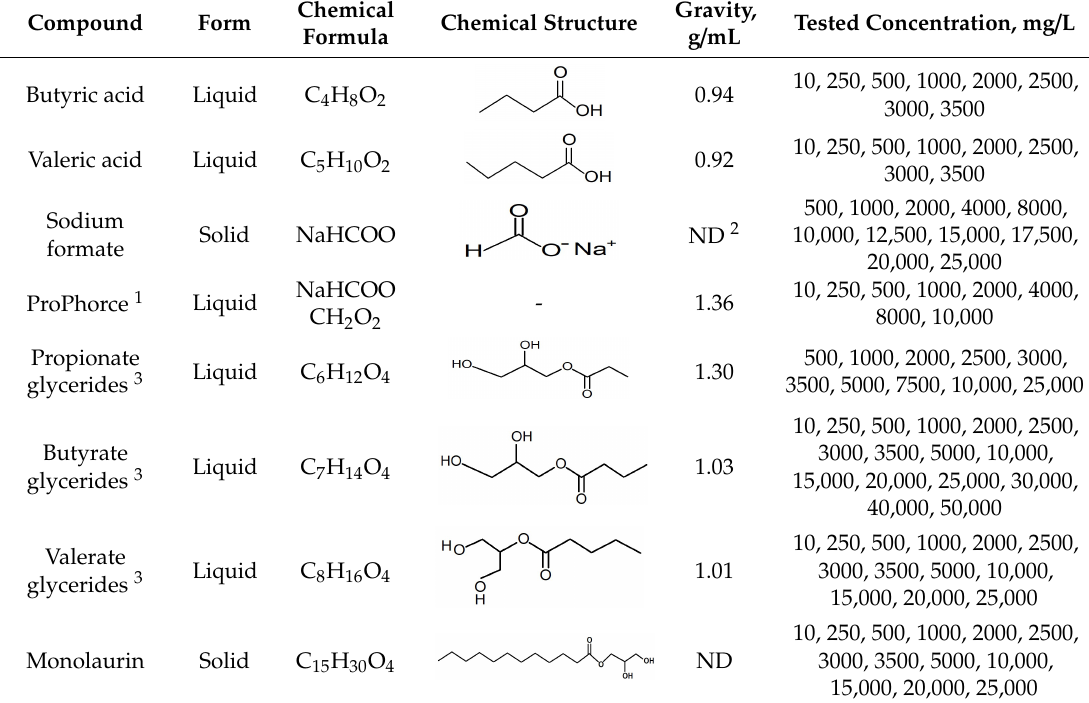
Table 1. Information of organic acids and their derivatives.